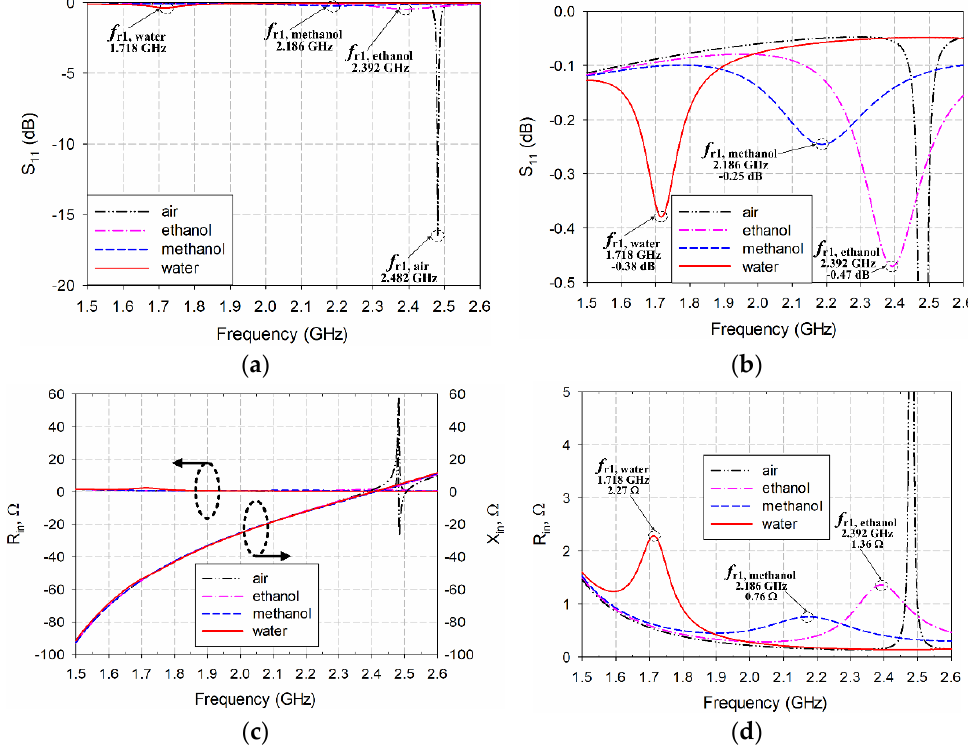
Figure 13. Responses of the scaled radiating edge ‐ aligned SR ‐ CSRR ‐ BCS slot ‐ loaded MPA with the liquid container at the center of the top ‐ edge when loss tangent of ethanol, methanol, and water was applied for the MUT: ( a ) input reflection coefficient with full magnitude range, ( b ) input reflection coefficient with zoomed ‐ in magnitude range, ( c ) input impedance, and ( d ) zoomed ‐ in input resistance.